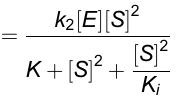
Figure 1. Screening and puri fi cation of chitinase MetaChi18A. A , Hydrolysis halo produced by MetaChi18A metagenomic clone (arrow) on colloidal chitin agar plate. B , SDS-PAGE of puri fi ed MetaChi18A. MM: molecular weight marker (kDa); Chi: puri fi ed MetaChi18A stained with Coomassie blue; Zymog: zymogram showing chitinolytic activity of puri fi ed MetaChi18A on colloidal